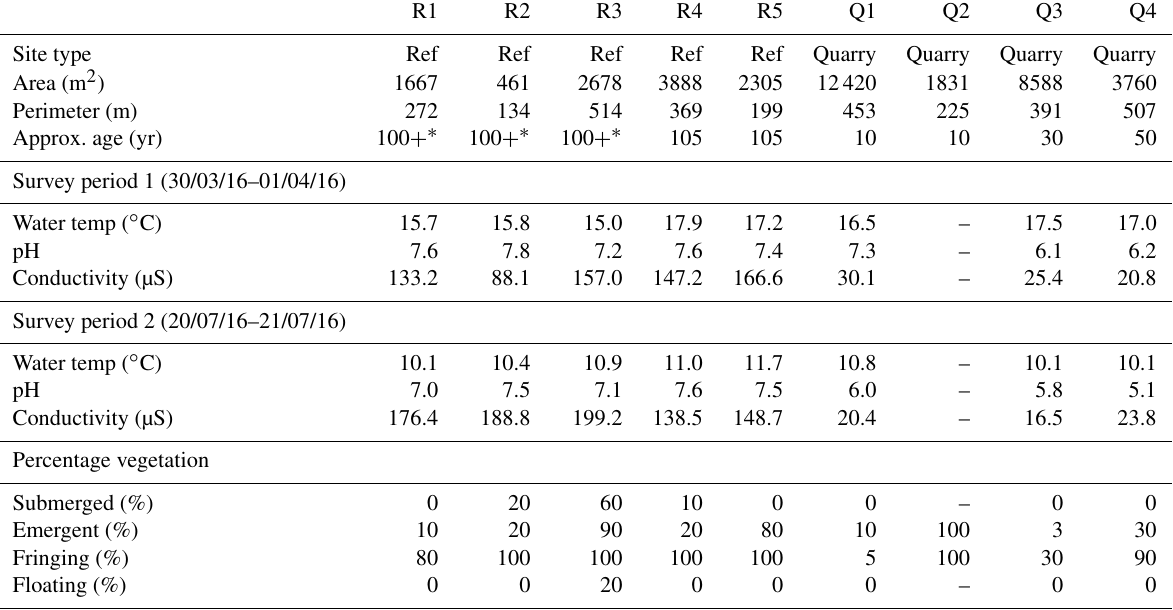
Table 1. Site characteristics including wetland area, perimeter and age, water quality data and the percentage cover of vegetation in various regions within wetlands. Reference wetlands (ref) – R1 is Geordie St Wetland; R2 is Laidley St Wetland; R3 is Vale of Clwydd Wetland; R4 is Lake Pillans Wetland 1; R5 is Lake Pillans Wetland 2. Quarry wetlands (quarry) – Q1 is settlement dam; Q2 is quarry swamp; Q3 is tailings storage cell; Q4 is